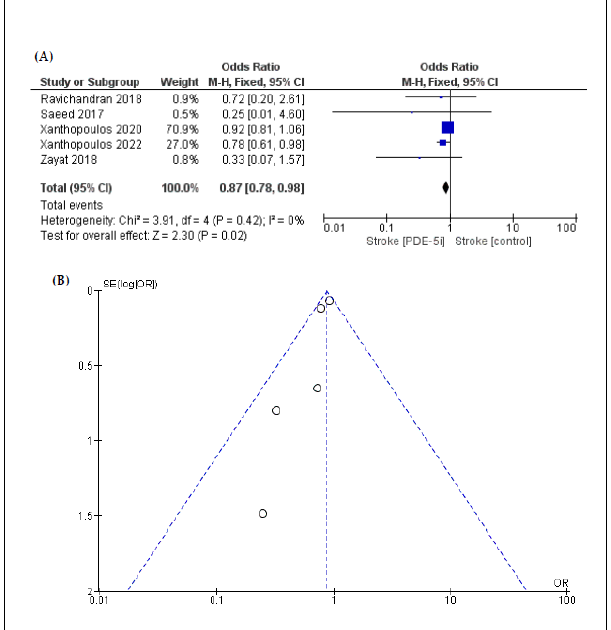
Figure 3. ( A ) Forest plot describing the differences in ischemic stroke between the 2 groups (PDE ‐ 5i vs. control); ( B ) funnel plot assessing the publication bias for ischemic stroke.